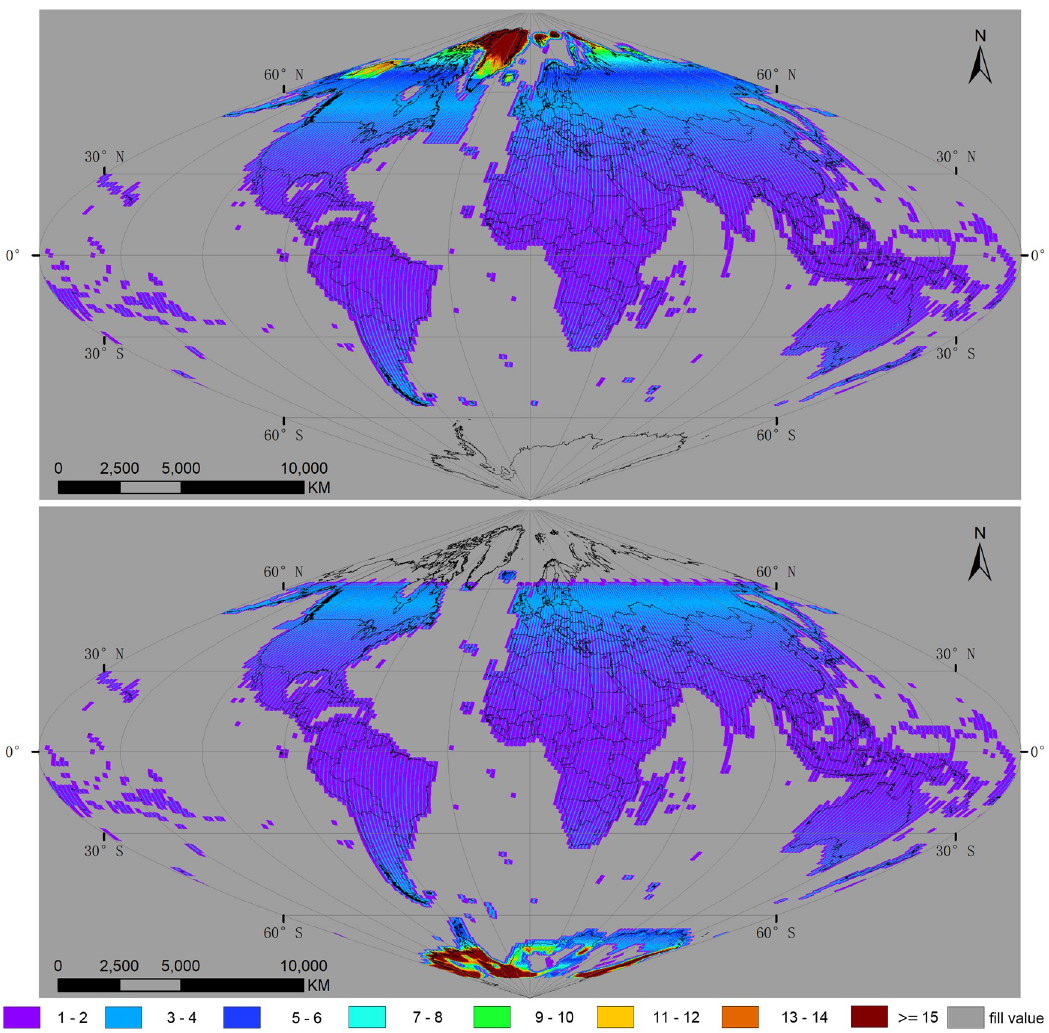
Figure 4. Total number of Landsat‐8 observations sensed over each land grid in June 2018 (upper panel) and December 2018 (lower panel). The results were examined on a global grid, defined by an equal area sinusoidal projection, composed of 7201 × 3601 grid points, with a spacing of 0.05°.